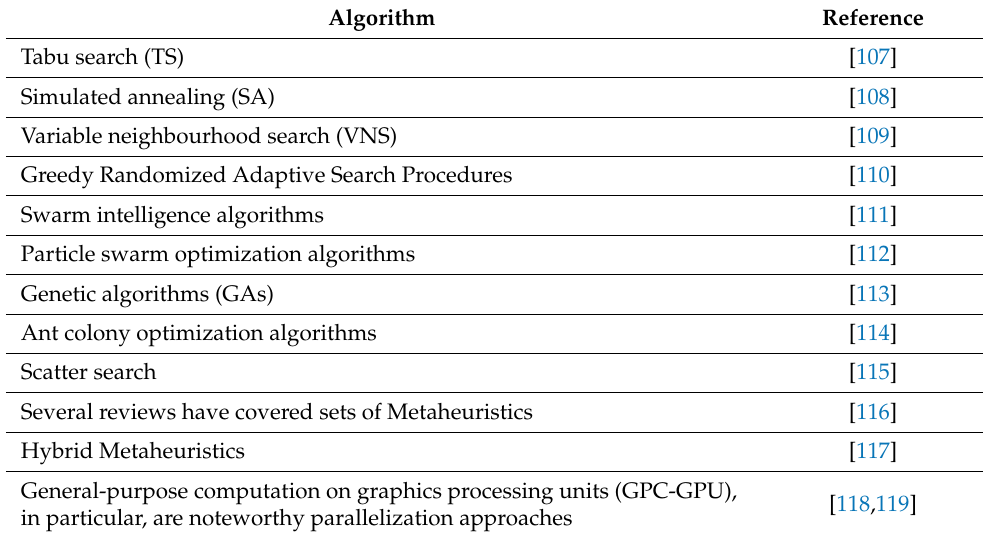
Table 2. Several parallel optimization methods and technologies use